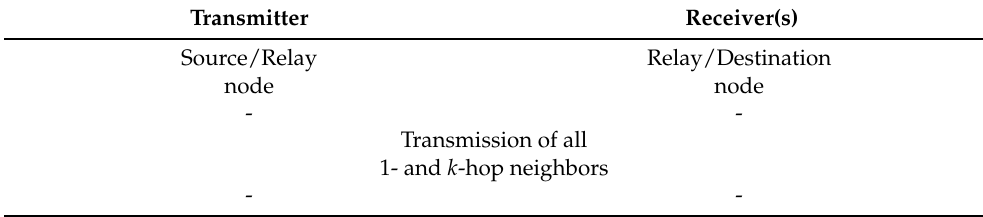
Table 2. Transmission table of node N i